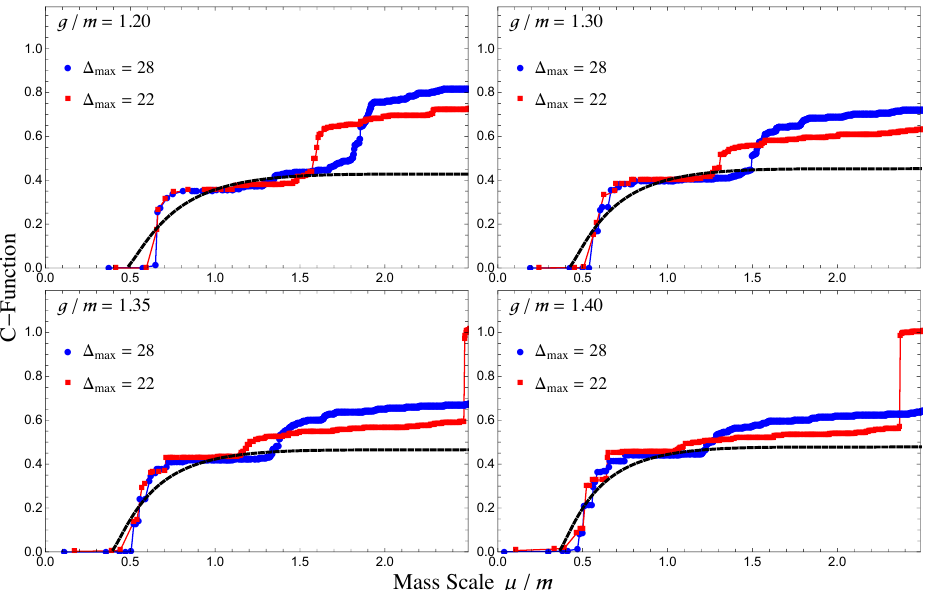
Figure 7 . Zamolodchikov C -function at different values of g near the critical point for ∆ max = 28 (blue dots) and ∆ max = 22 (red squares). The truncation data for SGNY is compared to the IR theoretical prediction for TIM from eq. (4.11) (black dashed line), which includes the effects of the relevant deformation (cid:15) 0 as well as the leading higher-dimensional operator ∂ 2 (cid:15) 0 . The value for m gap for the TIM prediction was obtained by fitting to the ∆ max = 28 data for the integrated C -function (see appendix C) at each value of g , while the value Λ ≈ 10 m was obtained by specifically fitting to the data at g = 1 .